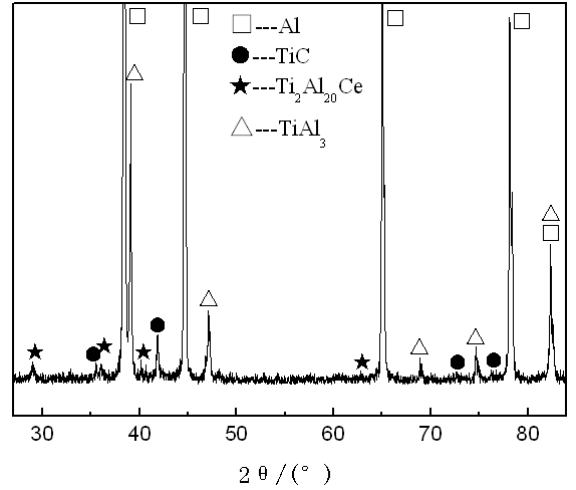
Figure 1. XRD pattern of Al-5Ti-0.62C-0.2Ce master alloy.